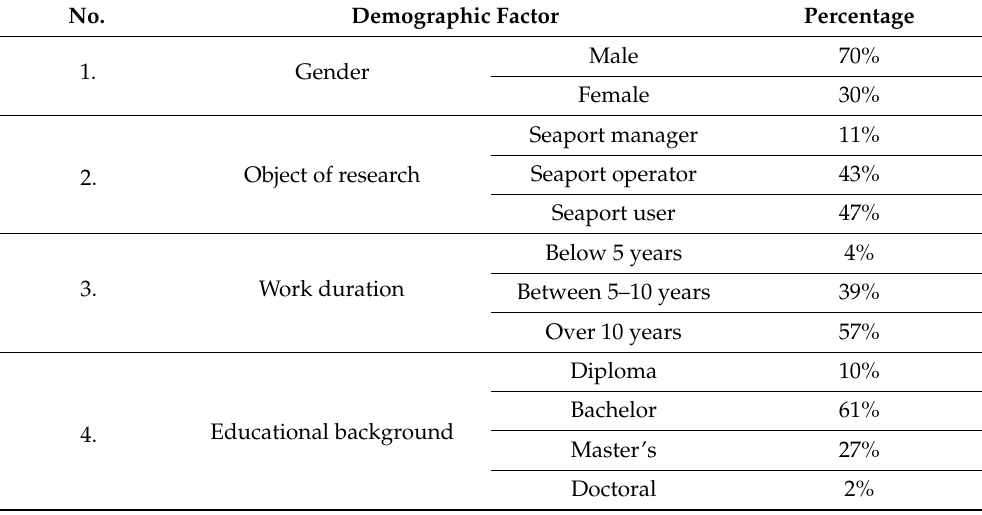
Table 3. Demographic information of